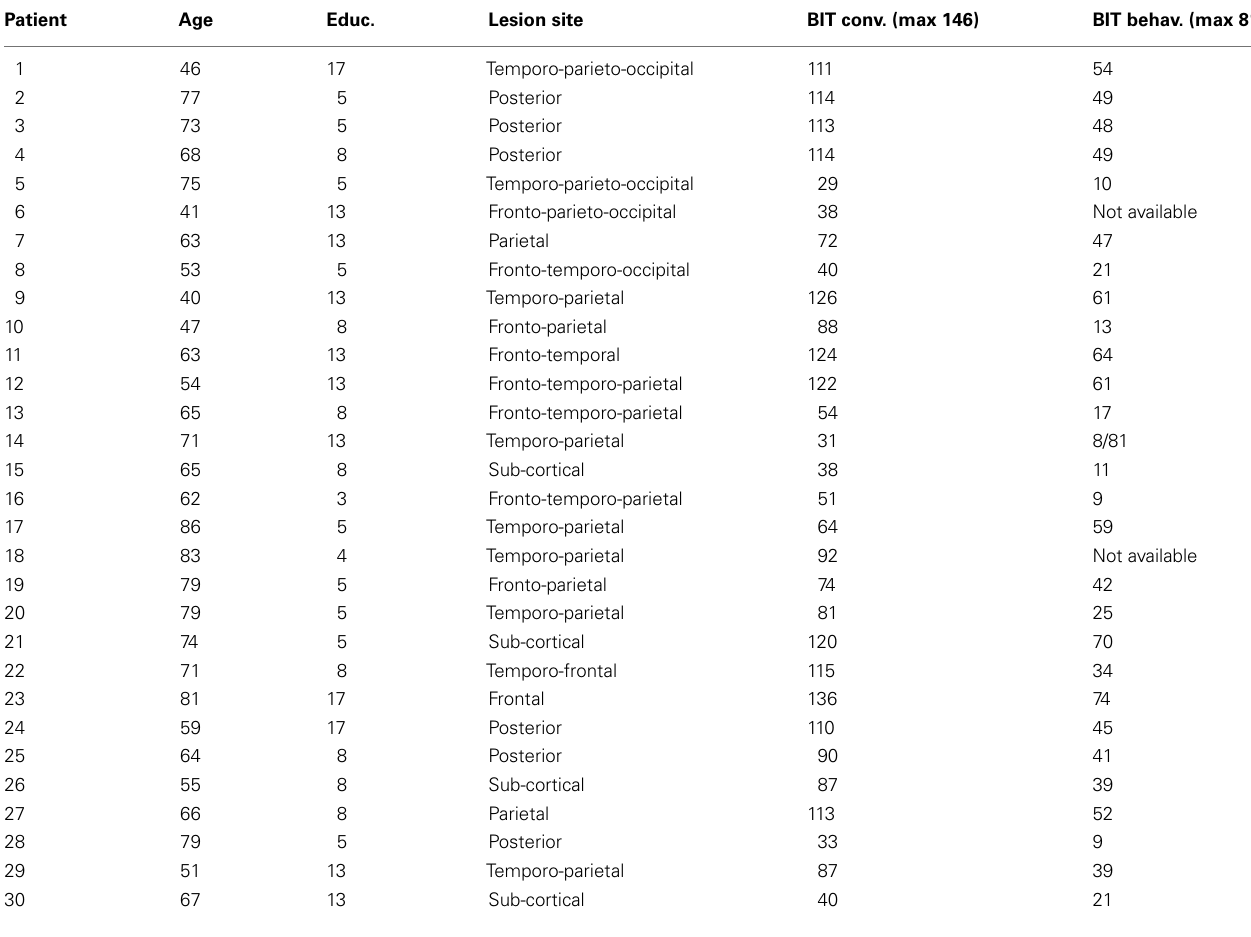
Table 1 |Age, years of education (Educ.), lesion site and performance on BIT conventional (BIT conv.), and BIT behavioral (BIT behav.) for each